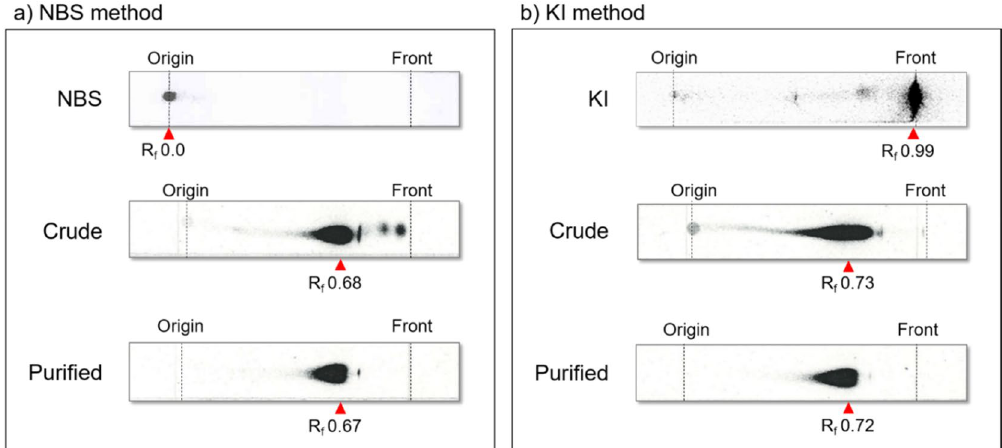
Figure 2. Radio-TLC analyses of 211 At-labeled intermediates and [ 211 At]APA. ( a ) NBS method: Reaction mixture after addition of NBS in the aqueous solution of 211 At (top); crude reaction mixture reacted with BPA, followed by the addition of ascorbic acid (middle); after SPE purification (bottom). ( b ) KI method: Reaction mixture after addition of KI solution in the aqueous solution of 211 At (top); crude reaction mixture reacted with BPA (middle); after SPE purification (bottom).